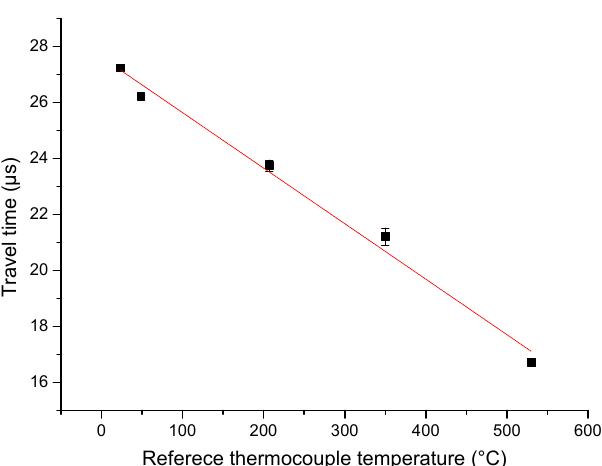
Figure 12. The relationship between travel time and thermocouple reference temperature.